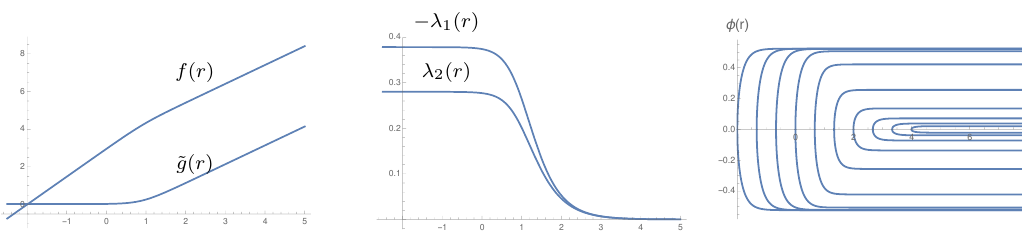
Figure 8 . AdS 7 → AdS 5 × T 2 flow solutions. The warp factors are both linear in the UV, corresponding to AdS 7 asymptotics, while ˜ g becomes constant in the IR and decouples, leading to AdS 5 × T 2 . The scalars transition from zero in the UV to non-zero values in the IR. Minimal surfaces are shown on the